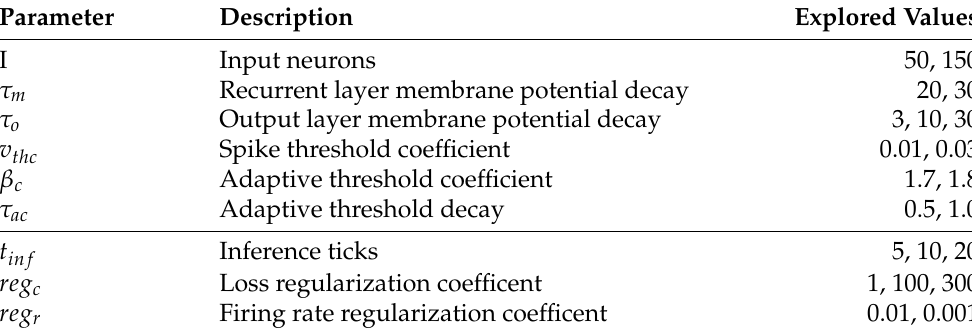
Table 1. LSNN parameters